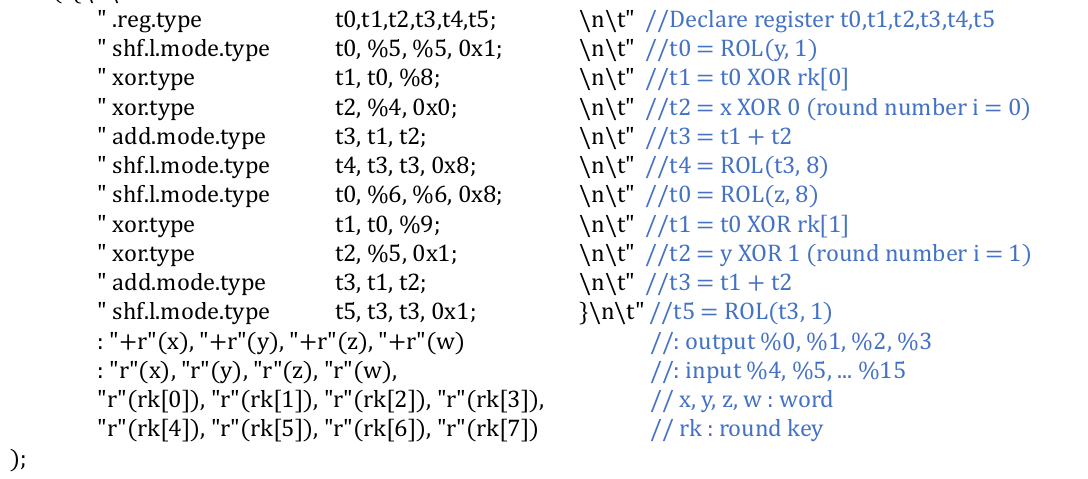
Figure 16. Example of inline PTX assembly codes of CHAM round